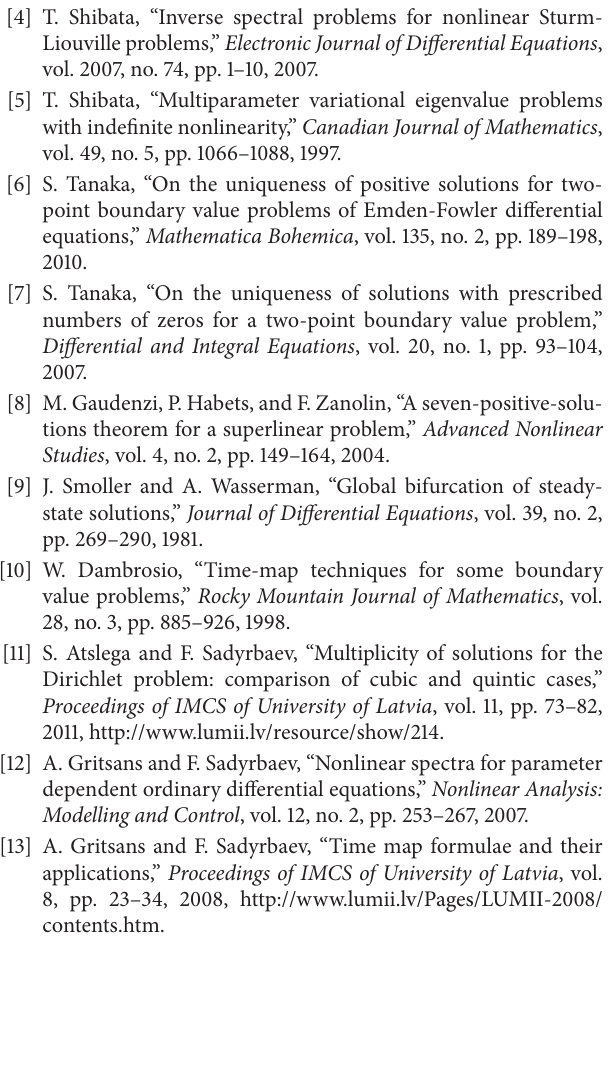
of the first zero function (time-map) 𝑇(𝛾) . These relative positions may be regulated by the choice of parameters , 𝑎 , . . . , 𝑎 𝑎 1 2 𝑘